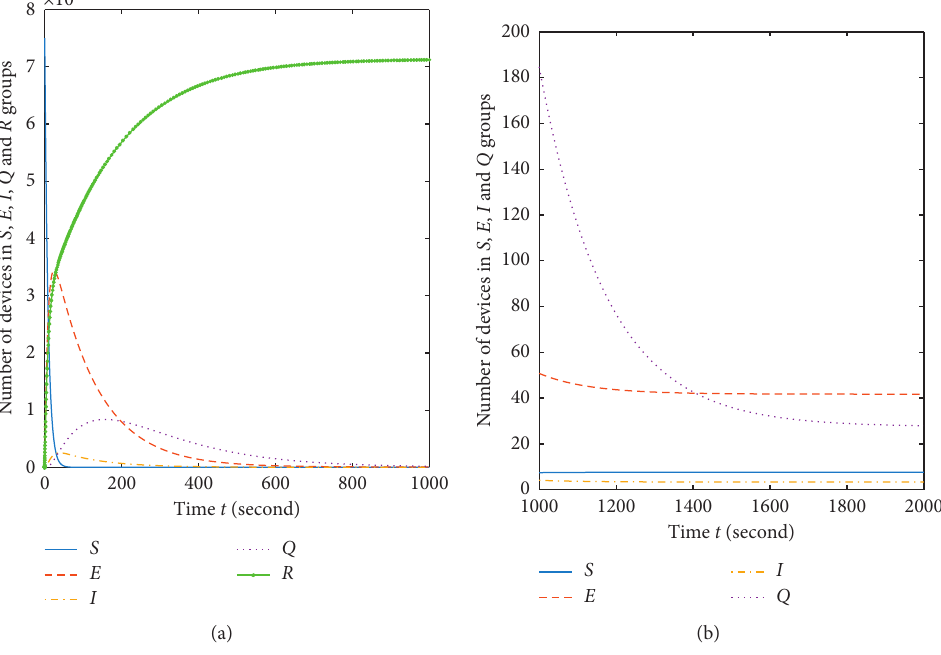
Figure 4: Dynamics of worm-existence